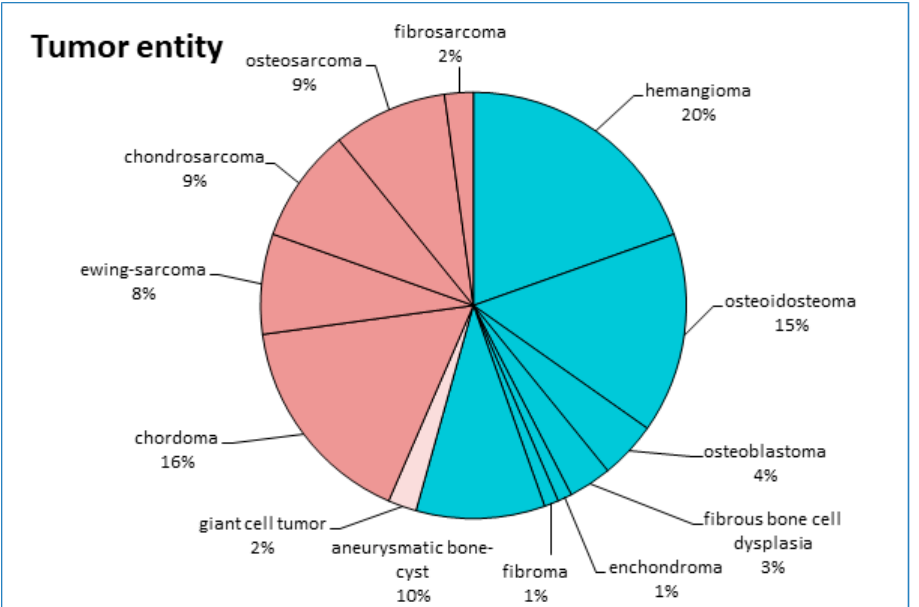
Figure 1. Tumor entities. Exact differentiation of tumor entities according to histopathological results. Total number of patients: 92. Groups divided into benign lesions (blue), semi-malignant lesions (beige), and malignant tumors (red).